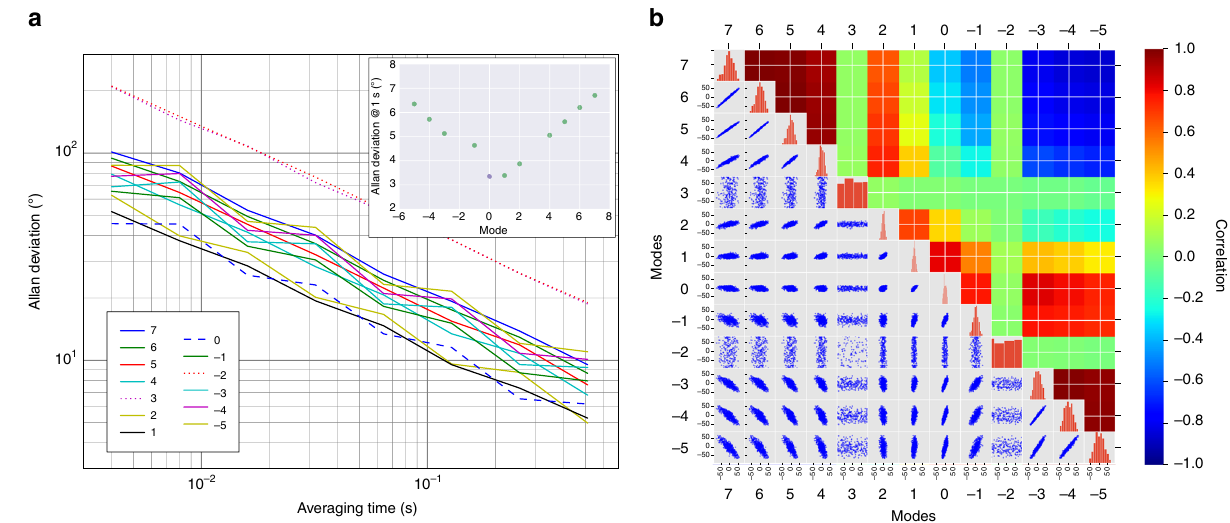
Fig. 5 Phase noise analysis. a Allan variance analysis on the phase of each comb mode during a 2-seconds-long acquisition. The characteristic trends con fi rm that the measurements are affected by statistical noise. Inset: linear dependence of extrapolated Allan deviation at 1 s on the mode order. b Correlation analysis on the phases fl uctuations. On the diagonal, the correlation matrix shows the distributions of each mode phase fl uctuations. Under the diagonal, the mutual correlation scatterplots of the modal phases are presented, while the corresponding correlation coef fi cient, color coded, is presented in the upper part of the matrix. The correlation and anti-correlation among all modal phases (except for modes − 2 and 3) con fi rms that the statistical noise detected is due to residual instabilities of the QCL-comb